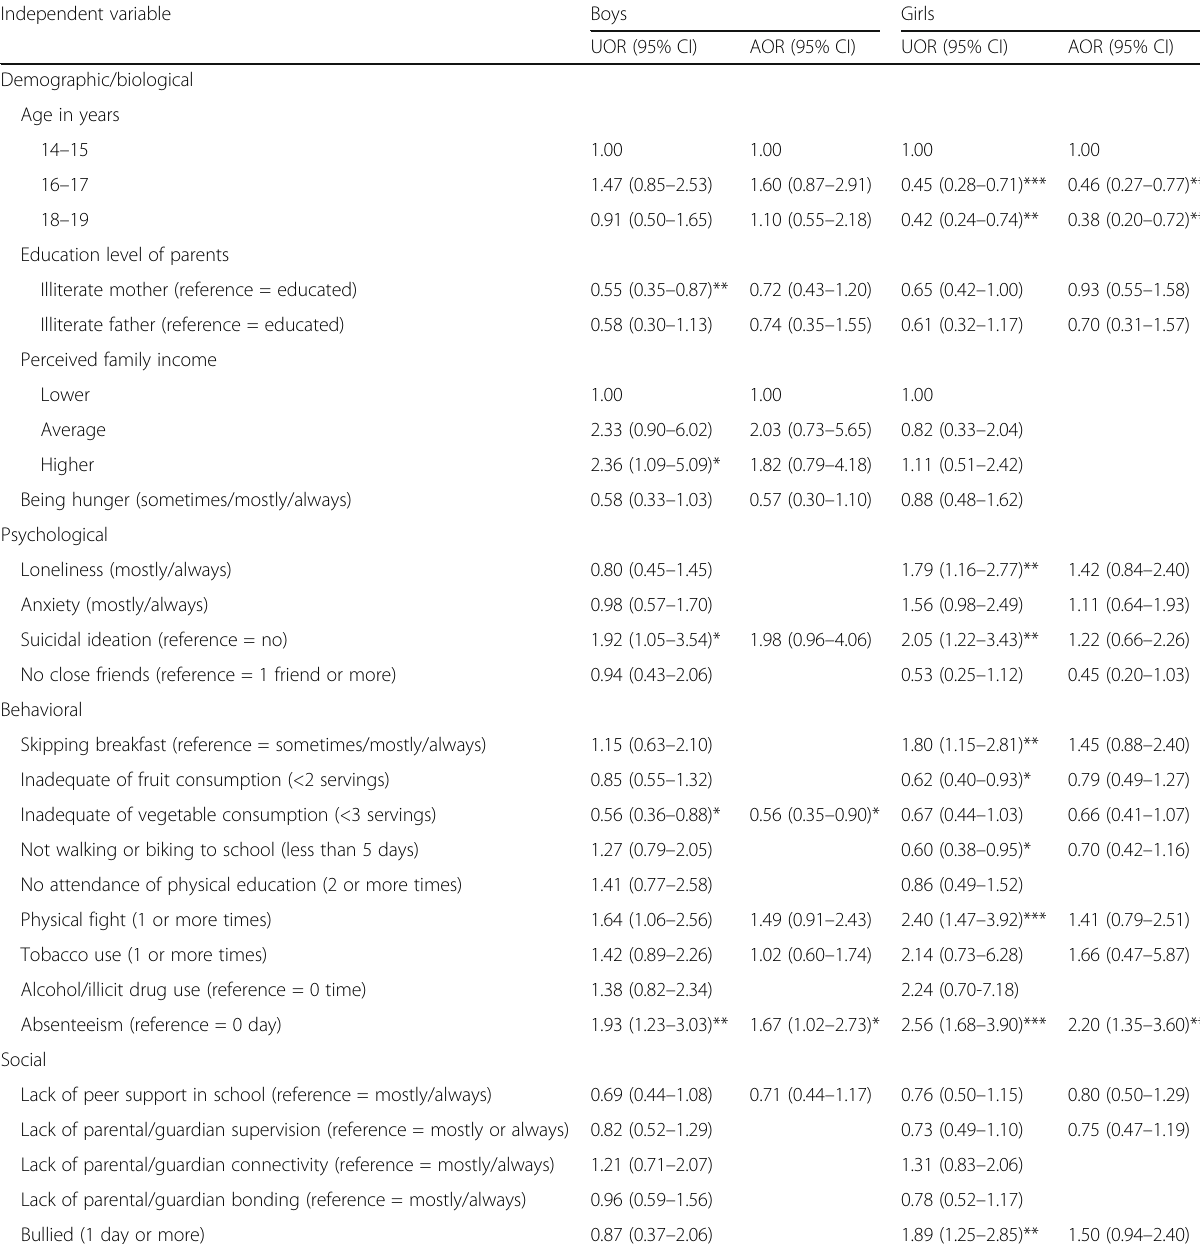
Table 3 Associations between sedentary behavior prevalence and independent variables in adolescents by gender Independent